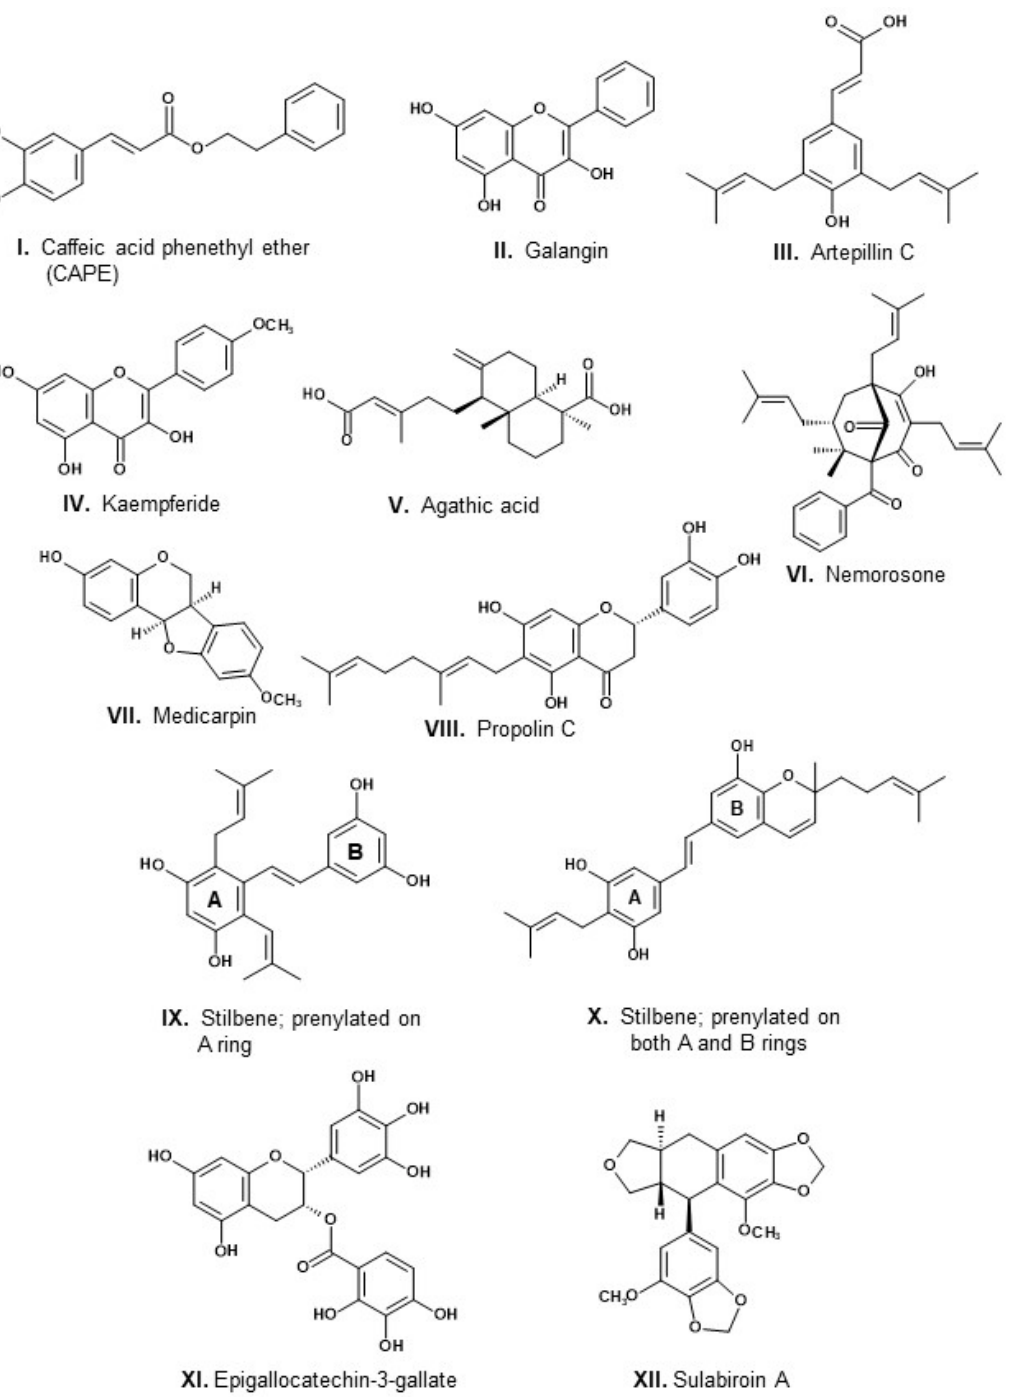
Figure 1. Structures of components of propolis. For correspondence between components and propolis types, see text.